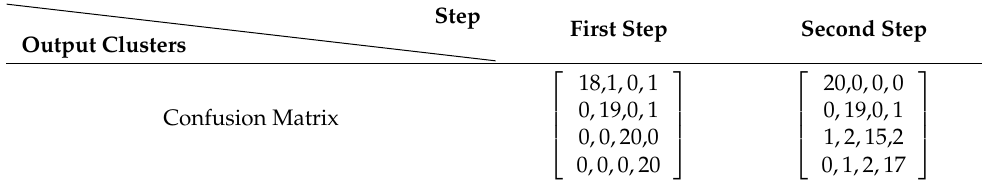
Figure 4. Proposed VFCSS clustering over input non-symmetric LR-type fuzzy numbers include four interference classes red, blue, black and green with (20,20,20,20) members, (first step of state 2). Figure 5. Proposed VFCSS clustering over input non-symmetric LR-type fuzzy numbers include four complexity interference classes red, blue, black and green with (20,20,20,20) members (second step of state 2). Table 10. CM of VFCSS applied over LR-type fuzzy numbers of Figures 4 and 5 (first and second steps of state 2).